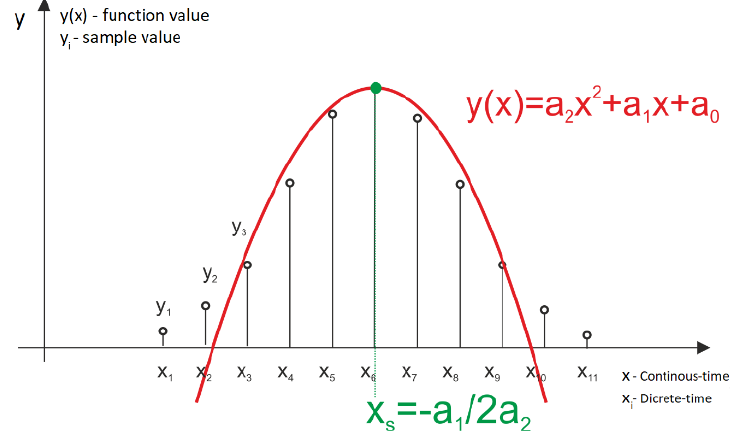
Figure 1. Approximation of a sampled signal with a second − degree polynomial (SDPA).